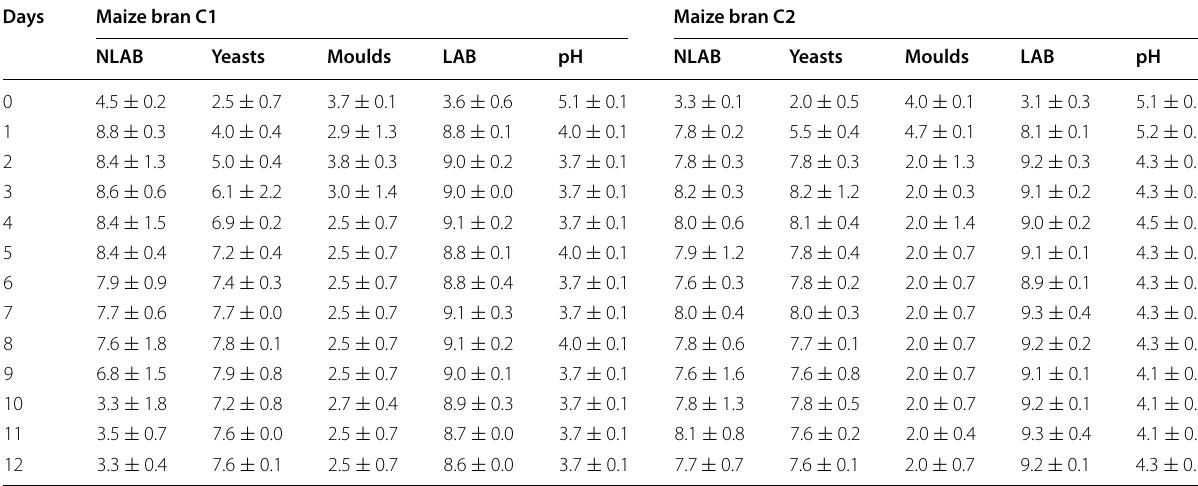
Microbial counts are measured in log CFU/g. Values are the means